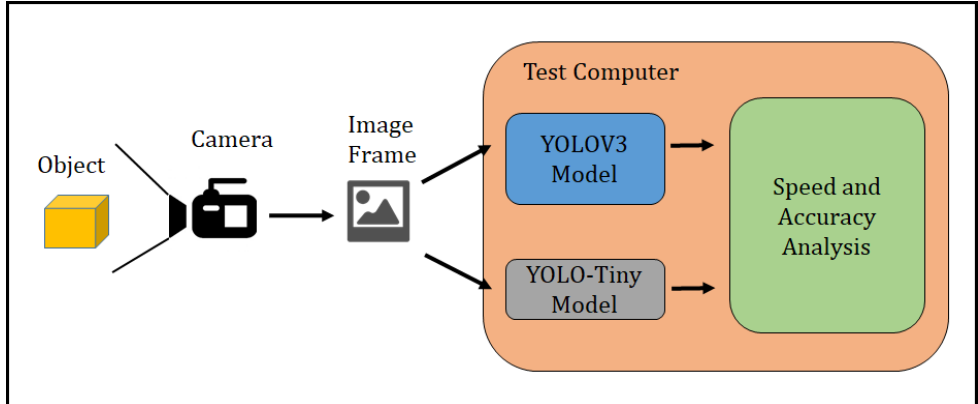
Figure 9. YOLOV3 and YOLO-Tiny accuracy-speed experiment set-up.